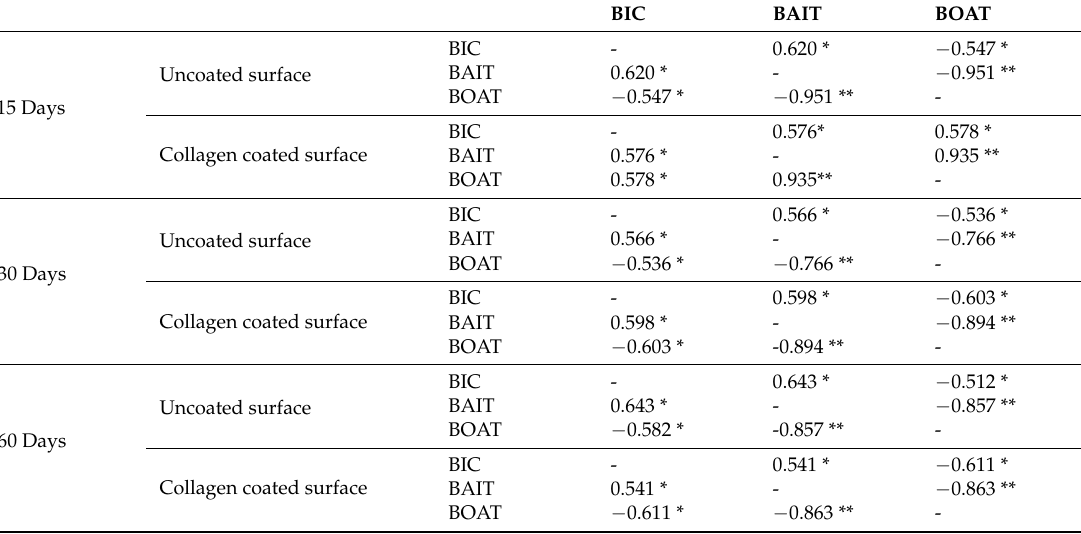
Table 3. The Pearson correlation results for the correlation between the Micro-CT BAIT and BAOT and histomorphometric BIC ratios. The Rho ( ρ ) values is the Pearson rank correlation coefficient. * p < 0.05; ** p <